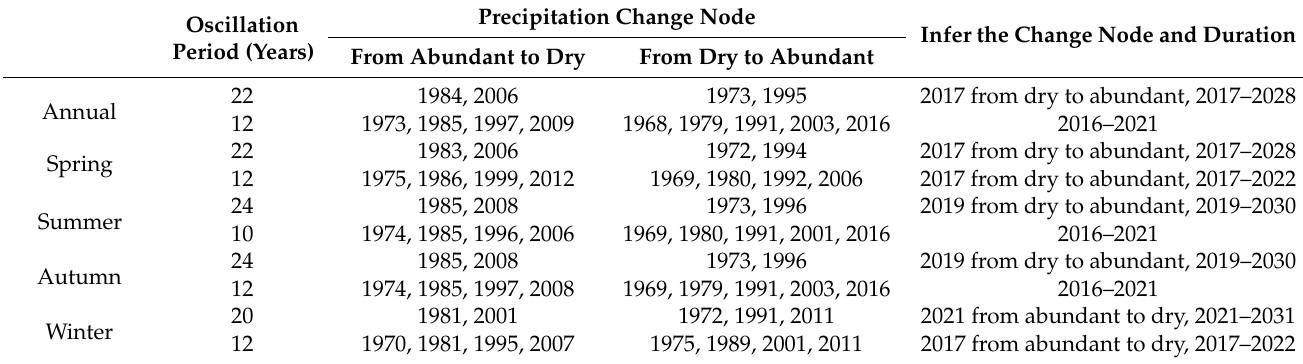
Table 2. Disruption points of real value of wavelet coefficient of annual and seasonal precipitation in QTP.